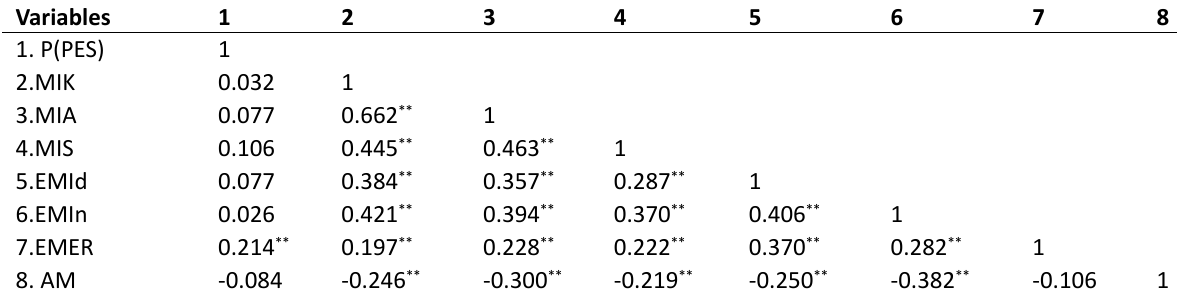
Table 2. Correlational analysis between performance in physical education and sport and motivation forms. Variables